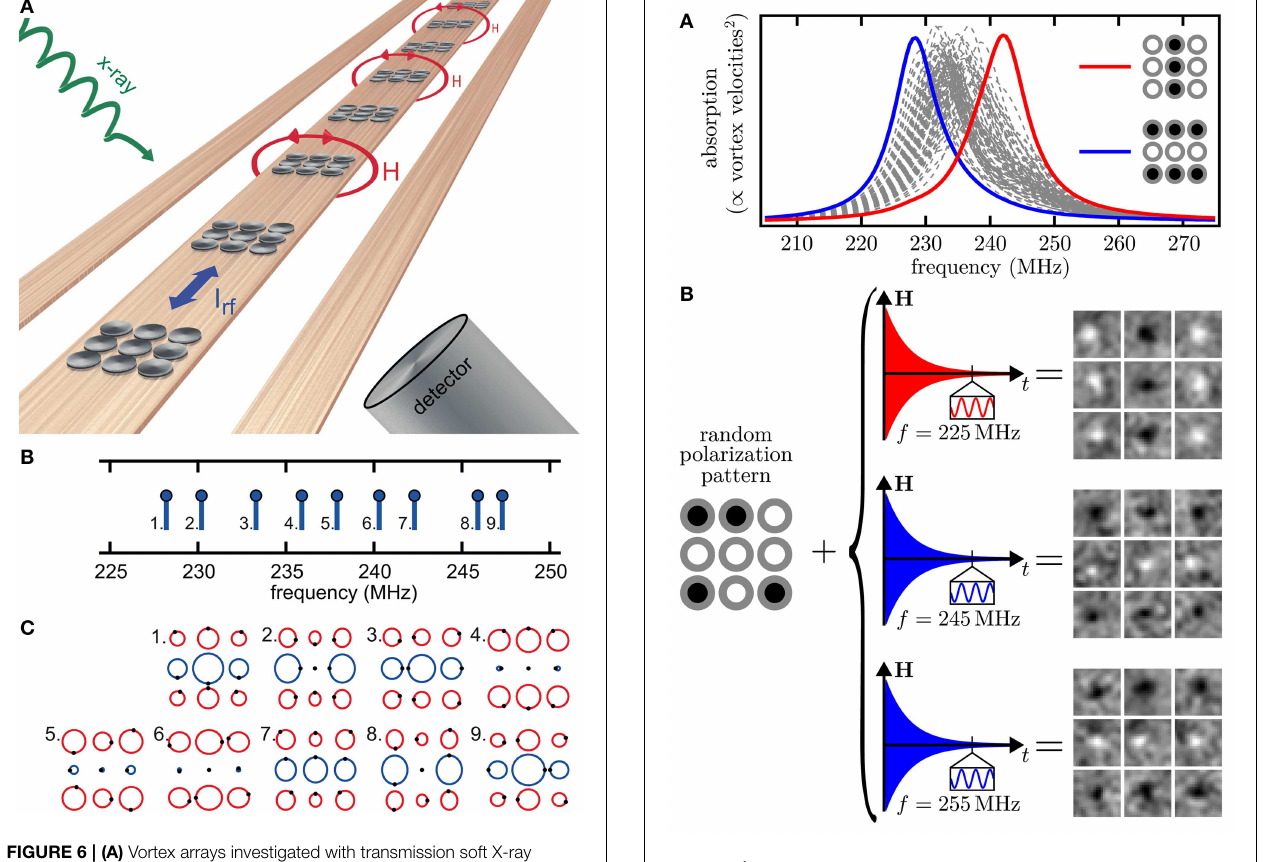
configurations are reached eventually [51]. The resulting state